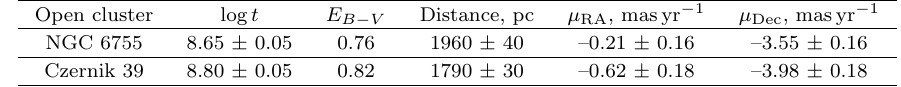
Table 1. Physical parameters of NGC 6755 and Czernik